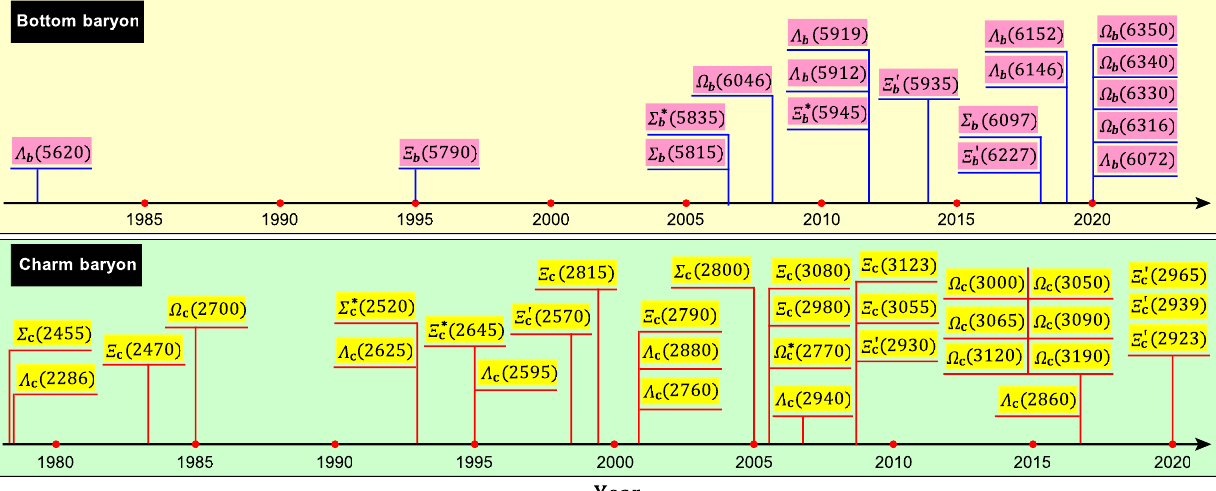
Fig. 1 All observed charm and bottom baryons